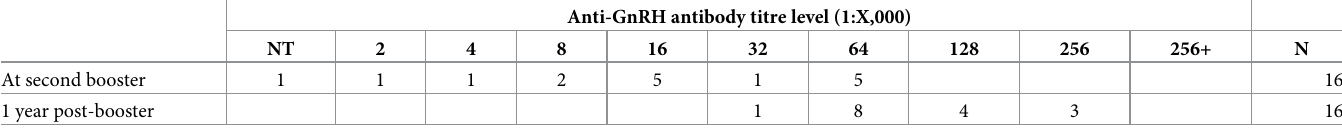
Table 3. Number of animals expressing anti-GnRH antibody titres in GonaCon Treated cattle, measured in samples collected one year after animals were adminis- tered a second booster dose of Gonacon in 2019.